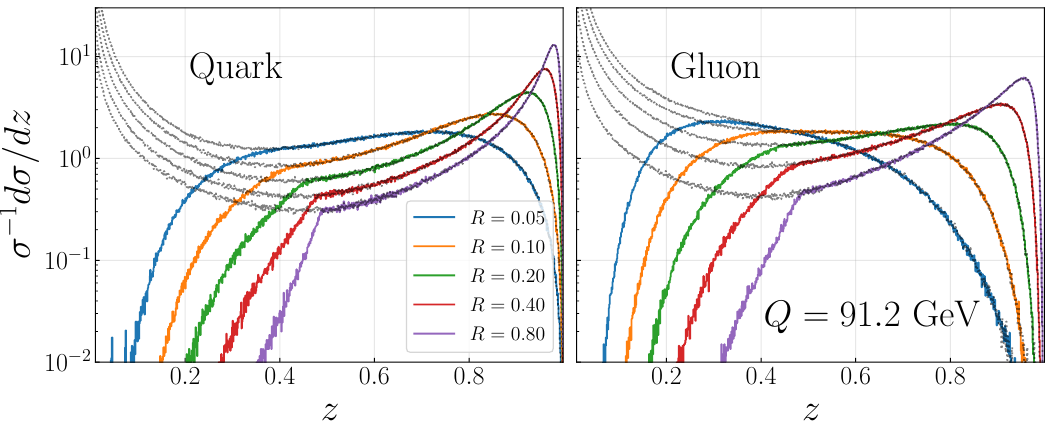
Figure 7 . The e + e − hemisphere leading jet cross section for different values of the jet radius R . We choose the same kinematics as in figure